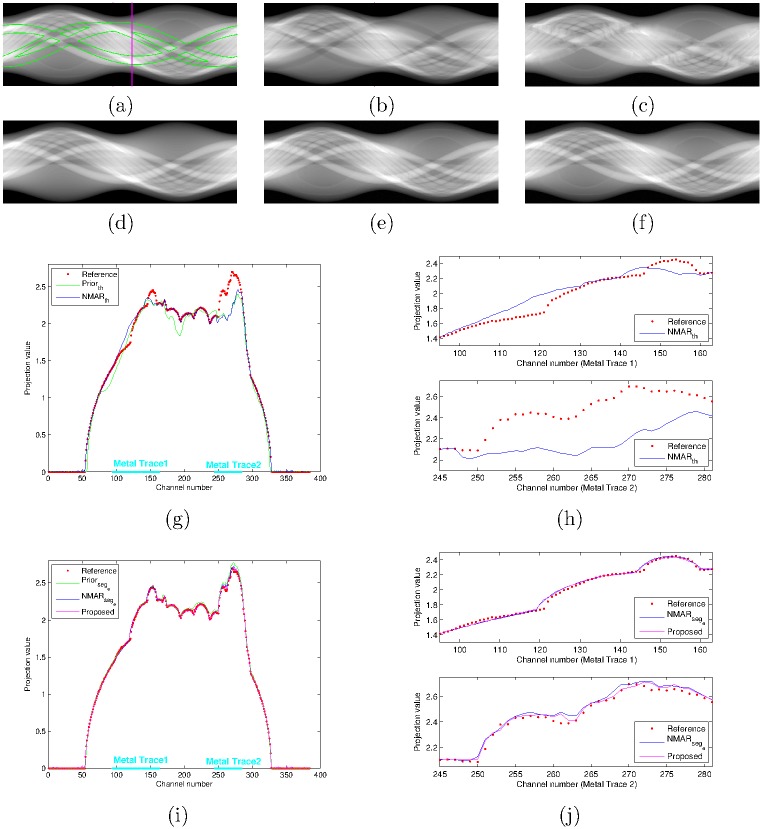
Sinogram profiles.(a) reference, (b) Priorth, (c) NMARth, (d) Priorsege, (e) NMARsege, and (f) the proposed algorithm. Comparison of sinogram profiles of (g) reference, Priorth, and NMARth, and (h) enlarged version of the profiles within metal traces 1 and 2 of Fig 8(g). Comparison of sinogram profiles of (i) reference, Priorsege, NMARsege, and the proposed algorithm, and (j) enlarged version of the profiles within metal traces 1 and 2 of Fig 8(i).